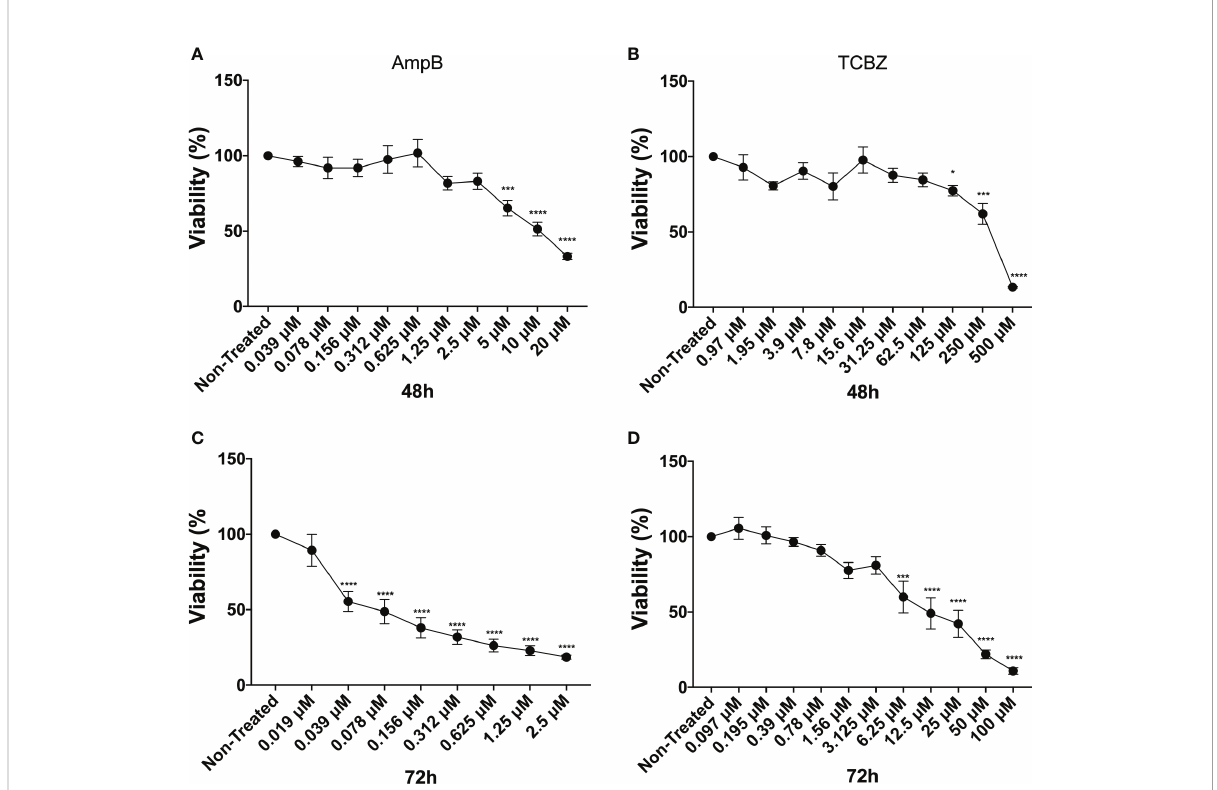
FIGURE 4 Cytotoxicity assay. Macrophages were treated with increasing concentrations of AmpB and TCBZ. Cytotoxicity evaluated by MTT assay after 48h and 72h of treatment with AmpB (A) and (C) , respectively. Cytotoxicity evaluated by MTT assay after 48h and 72h of treatment with TCBZ (B) and (D) , respectively. * = p < 0.0332, *** = p < 0.0002, **** = p <